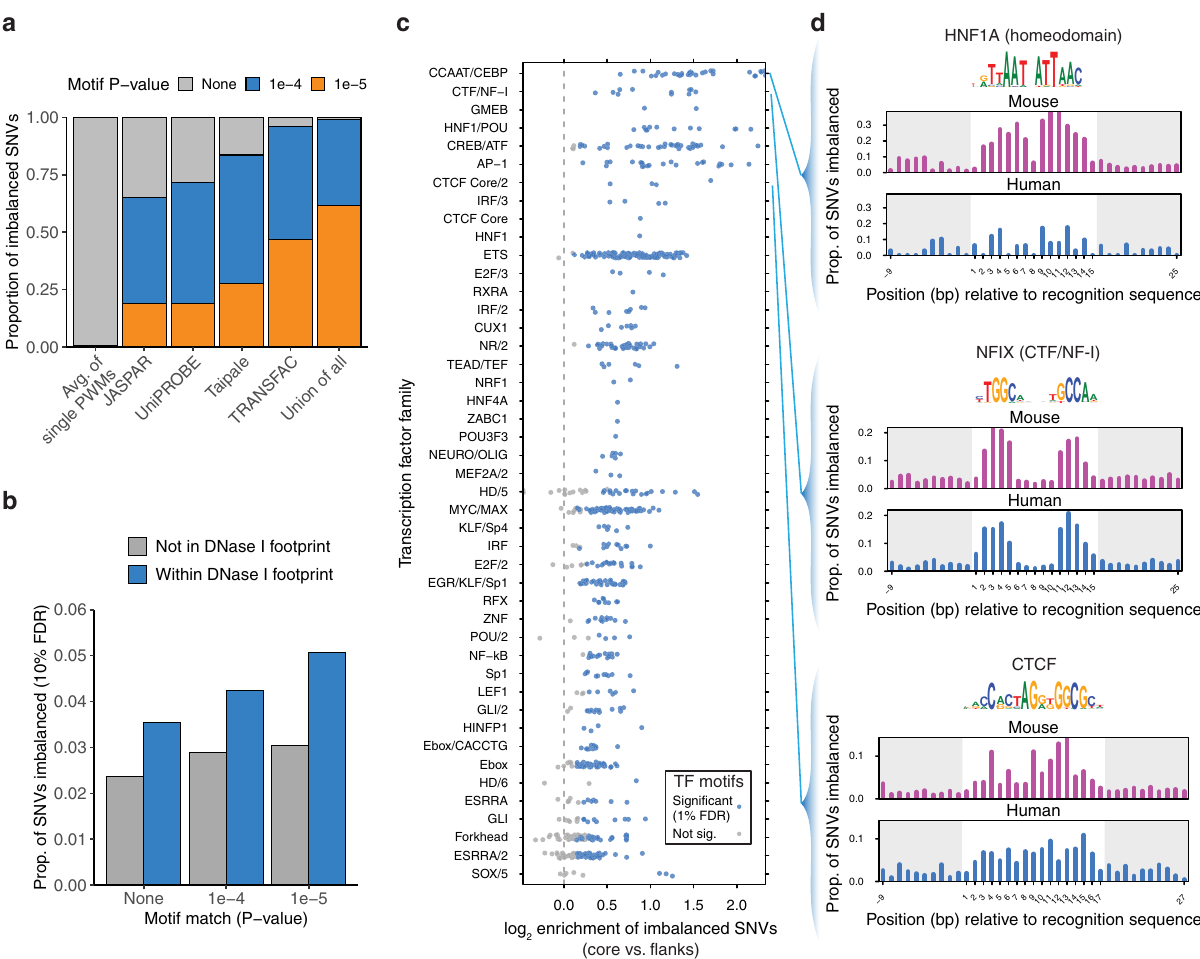
Fig. 4 Analysis of variation affecting TF occupancy. a Overlap of imbalanced SNVs with matches to TF motifs from different large-scale collections. b . Frequency of aggregate imbalance at SNVs overlapping TF motifs from a large-scale SELEX-seq database 48 and DNase I footprints aggregated across all cell types. Results are strati fi ed by the FIMO value of overlapping TF motifs (if any). n = 357,303 SNVs. c Enrichment by TF family of imbalanced SNVs in TF core recognition sequences, relative to fl anking sequence. Each point corresponds to a TF motif, grouped into TF families on the Y -axis. Shown are TF families with at least one enriched motif. d TF pro fi les for NFIX, CTCF, and HNF1A. For comparison, pro fi les generated from published analysis in human 4 are shown below in